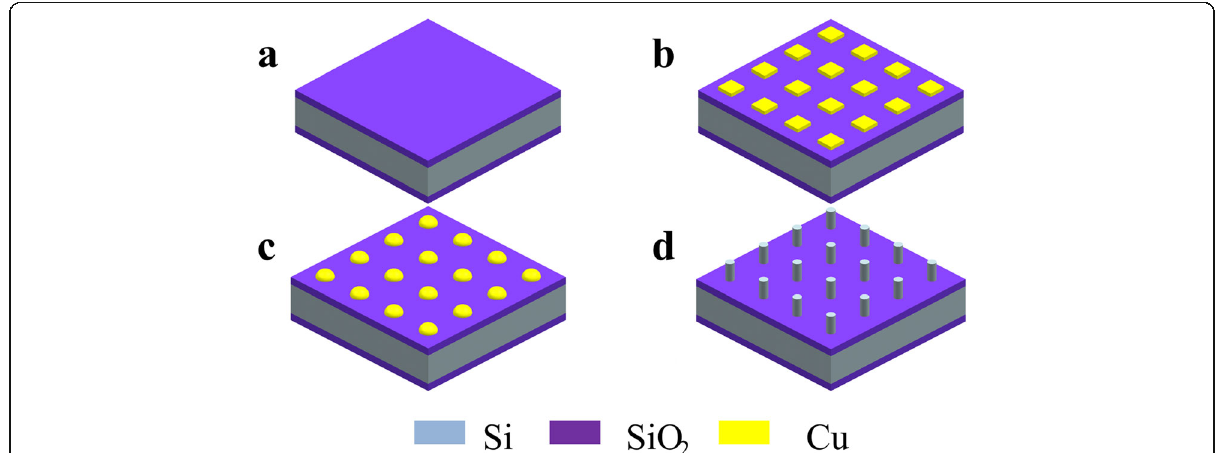
Fig. 1 Schematic depiction of the fabrication process. a Thermal oxidation. b Cu micron-size pattern array fabrication. c Copper patterns changed into hemispheres. d Nanowire